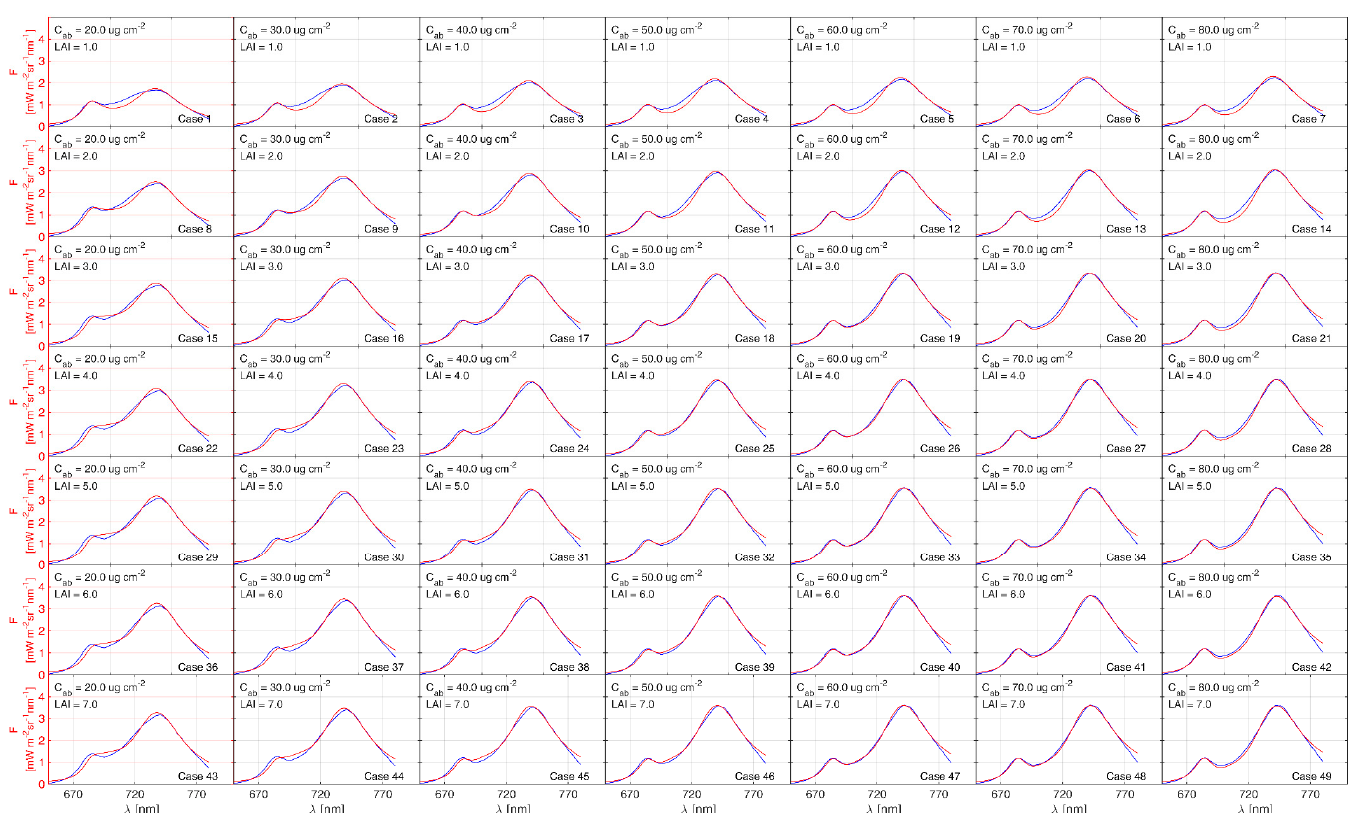
Figure 8. Comparison between F spectrum retrieved ( red ) and reference ( blue ) for all the simulated cases.